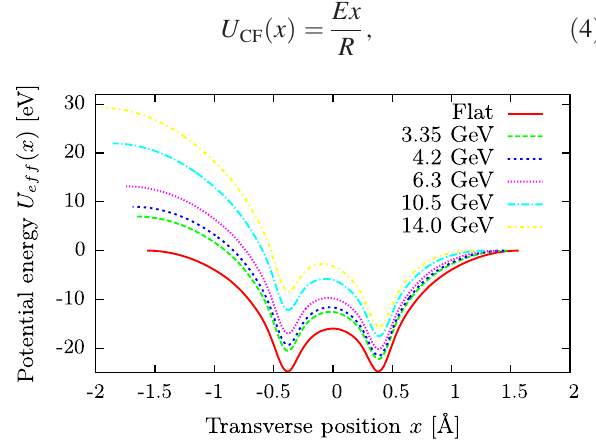
FIG. 1. A plot of the effective potential of Eq. (5) for a flat crystal and for the relevant electron energies with bending radius R ¼ 0 .